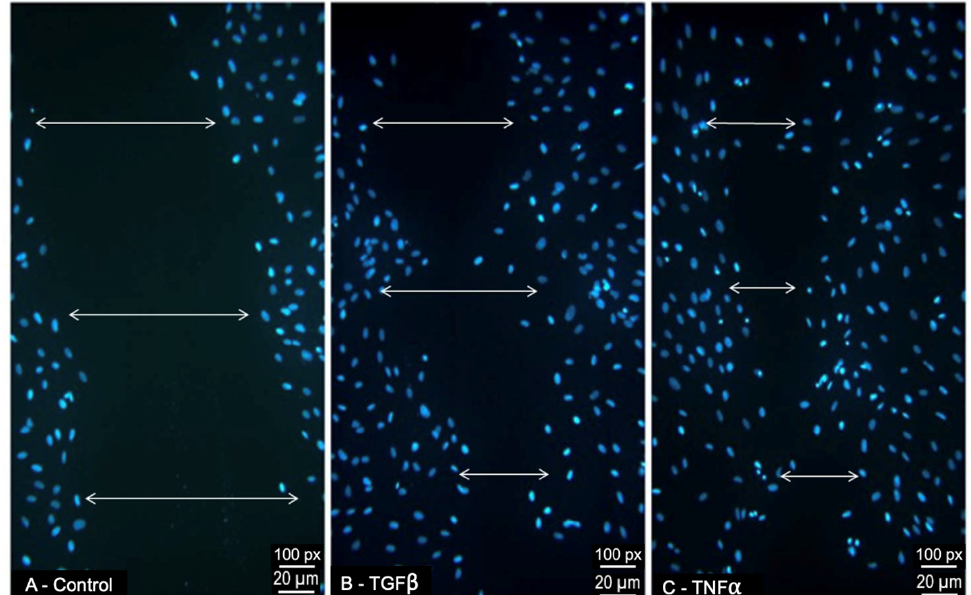
Figure 4. ARPE19-cell migratory response to treatment with pro-fibrotic cytokines ( B ) TGF β 1 (10 ng/mL) and ( C ) TNF α (10 ng/mL) during scratch migration assay. The ARPE19 cells stained with nuclear marker DAPI (blue), 24 h after the infliction of a scratch wound. Migration was calculated as pixels (px)/hour. Scratch wounds, indicated with white arrows, were measured. Control ( A ) scratch